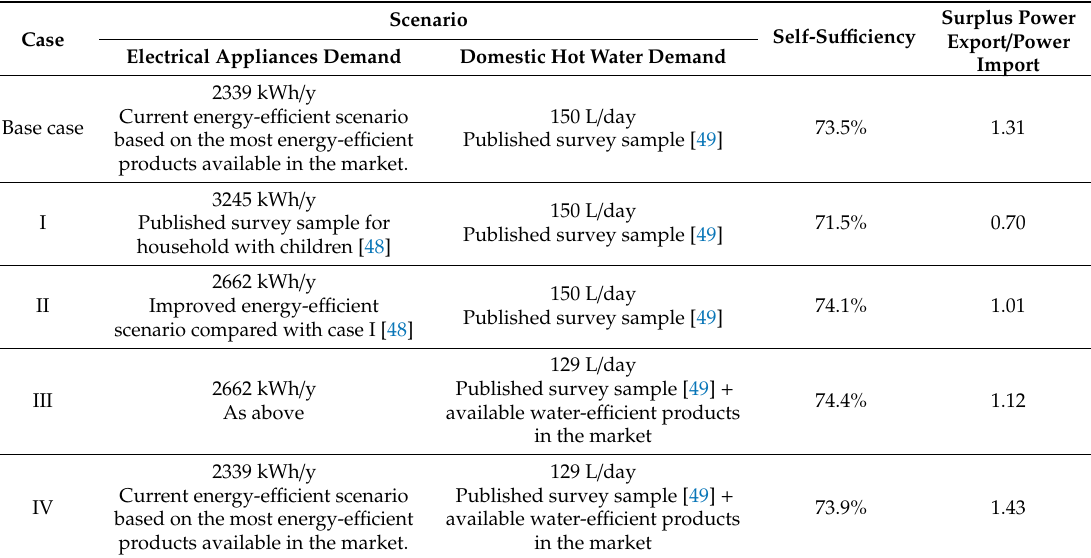
Table 10. Performance prediction of di ff erent